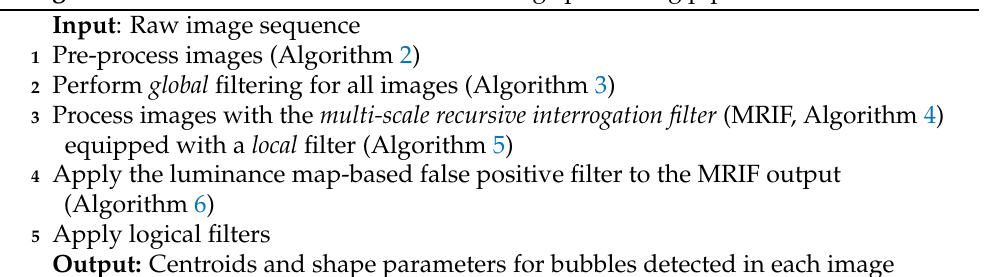
Algorithm 1: Overall structure of the new image processing